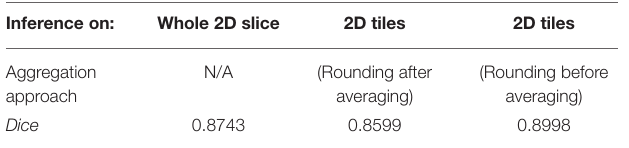
TABLE 1 | Results of 2D U-Net on medical data (BraTS). Inference